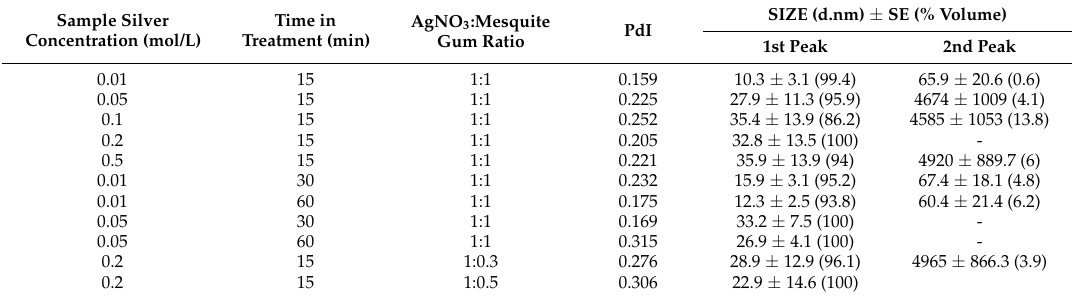
Table 1. Measurements of the effective hydrodynamic diameter (DLS data) of Ag NPs samples synthesized at different conditions.